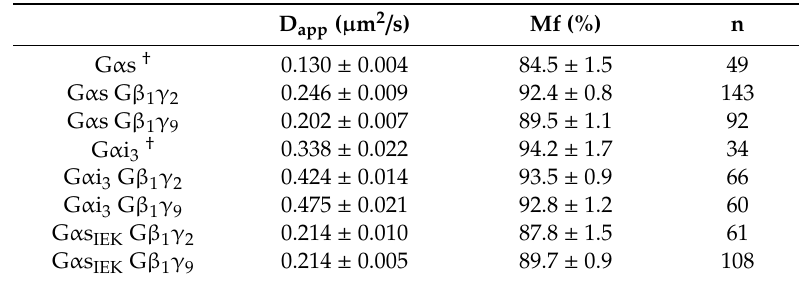
Table 1. Lateral di ff usion coe ffi cients of investigated G α subunits fusion protein constructs in the presence of G β 1 γ 2 or G β 1 γ 9